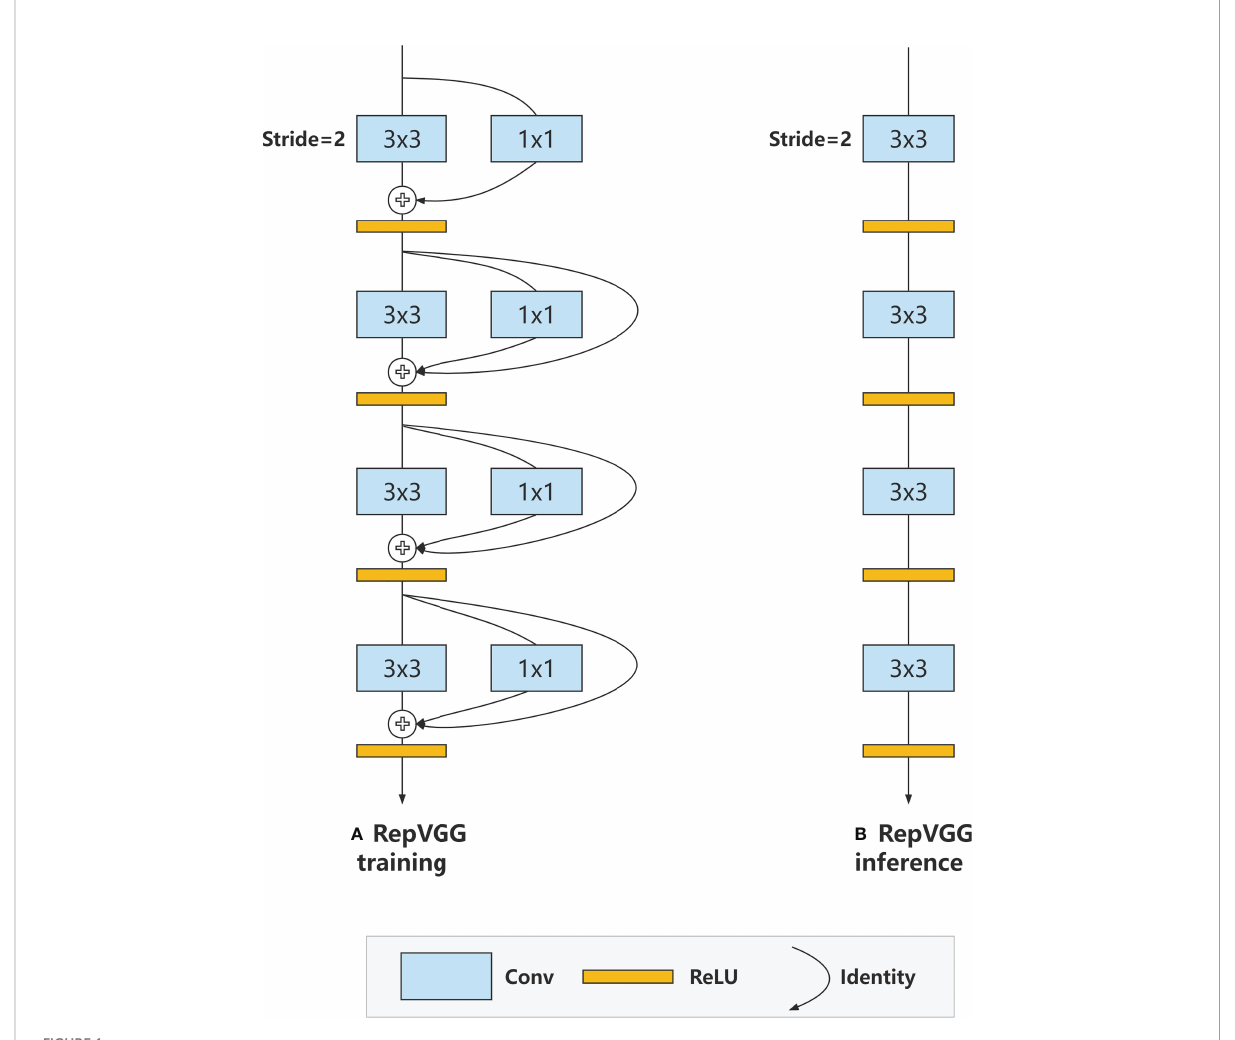
FIGURE 1 RepVGG Block structure, using a multibranch structure during training and a single-way structure during the inference